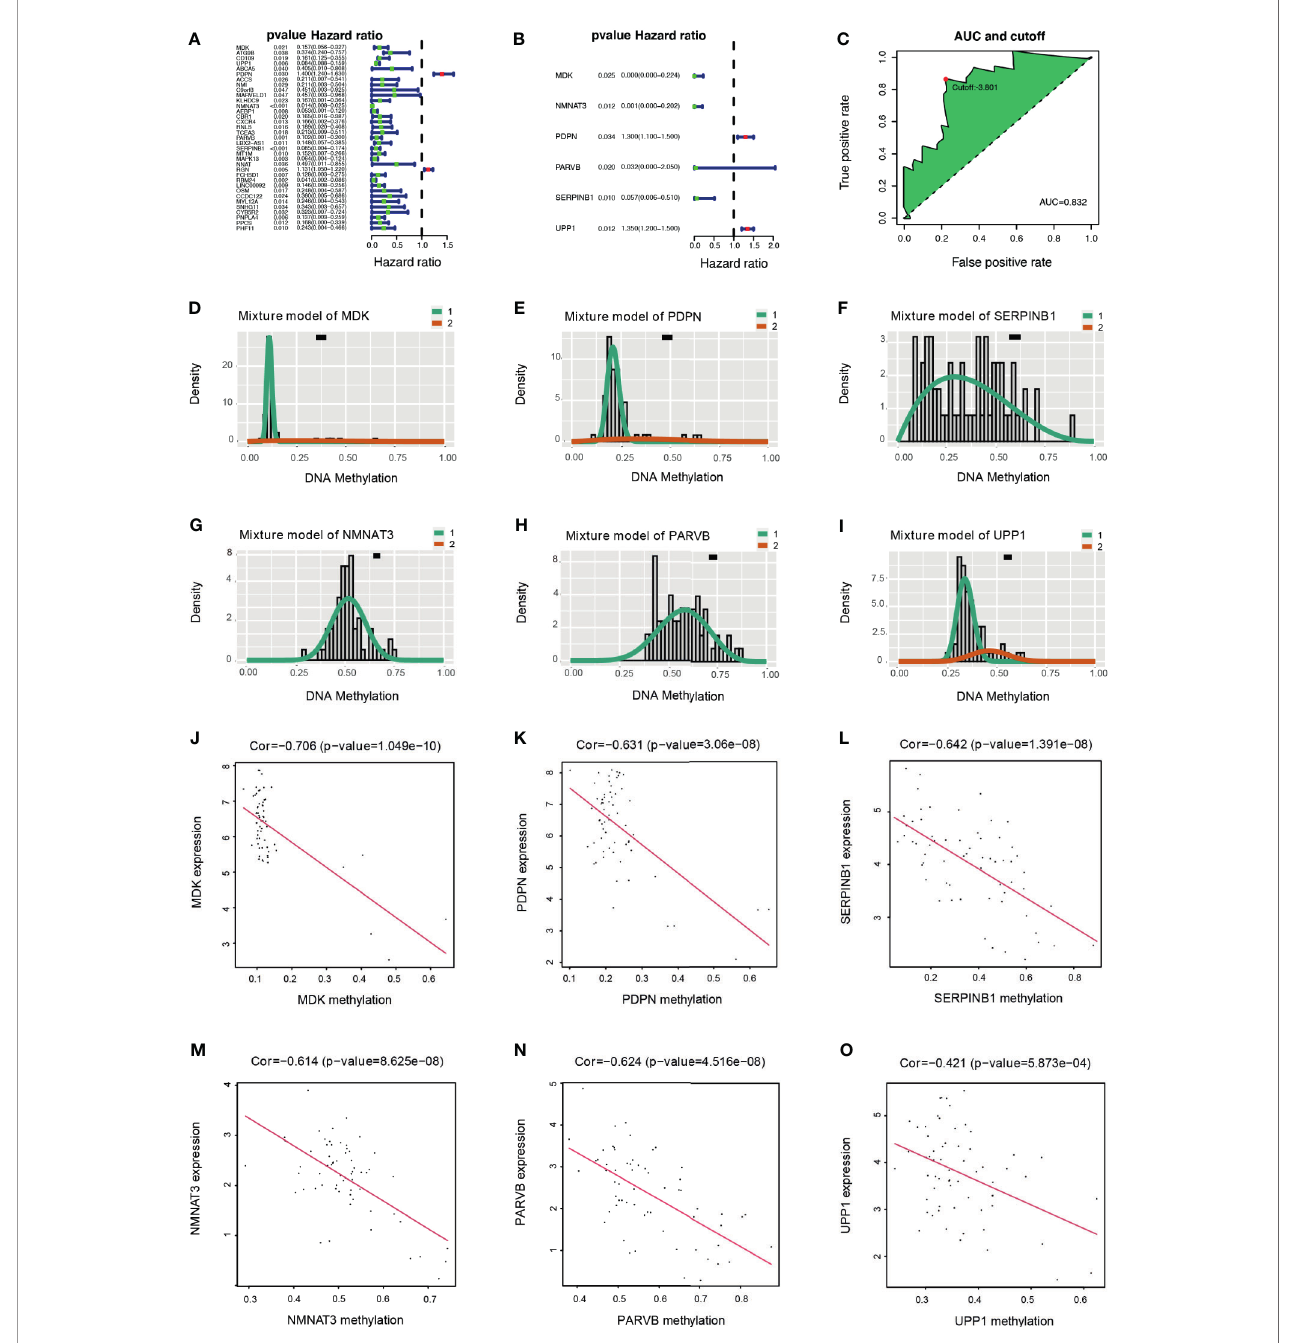
FIGURE 4 | Construction of DMDG prognostic model and Relationship of expression levels and methylation values of six DMDGs. (A) Forest plot of 35 DMDGs selected by univariate Cox regression analysis associated with GBM survival in the training set. (B) Forest plot of 6 DMDGs selected by multivariate Cox regression analysis associated with GBM survival and construction risk model. (C) The AUC value and cut-off point obtained in the risk model. (D – I) Distribution map of the methylation level of the six genes ( MDK , NMNAT3 , PDPN , PARVB , SERPINB1 , and UPP1 ) comprising the risk model. The X- and Y-axes represent the degree of methylation and the number of methylated samples, respectively. The black horizontal line indicates the distribution of methylation degree in normal samples. (J – O) Correlation of expression levels and methylation values of the MDK , NMNAT3 , PDPN , PARVB , SERPINB1 , and UPP1 genes in the risk model. The X- and Y-axes indicate the degree of methylation and the level of gene expression,